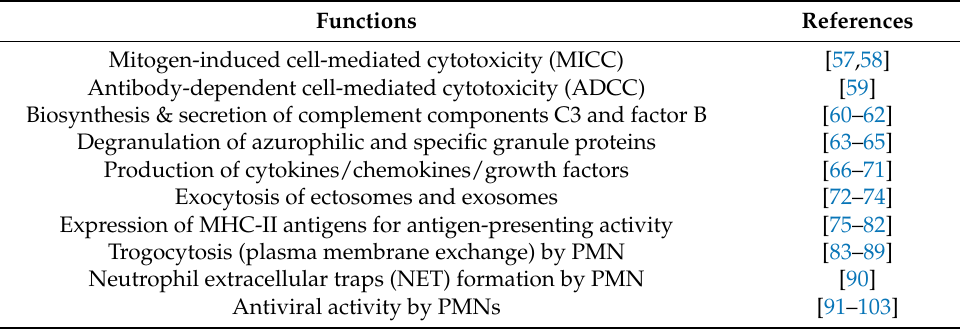
Table 1. Novel biological/immunological functions of PMN.